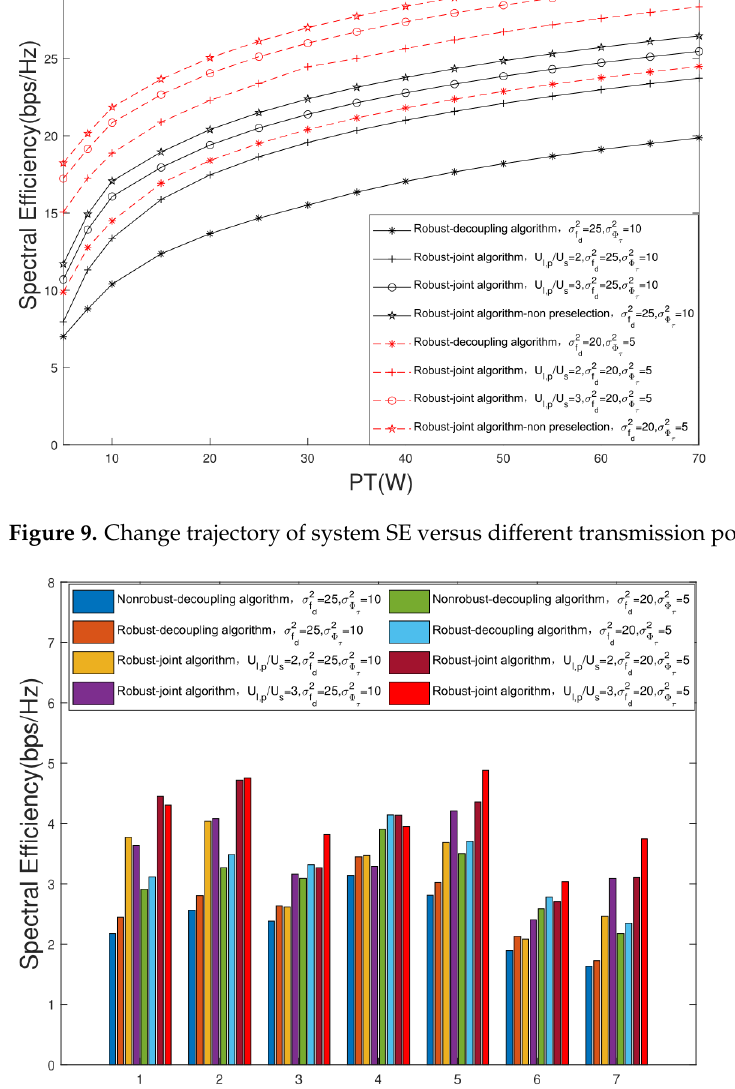
Figure 10. Comparison of SE of different multicast groups.